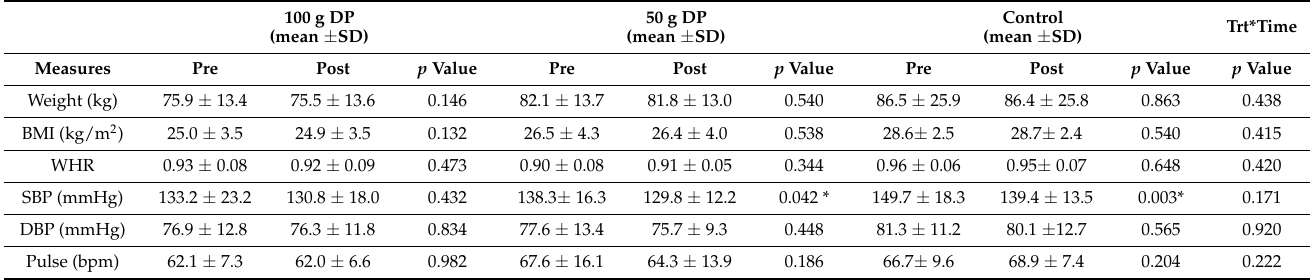
Table 2. Anthropometric and vital measurements at baseline (Pre-) and 3 months (Post).